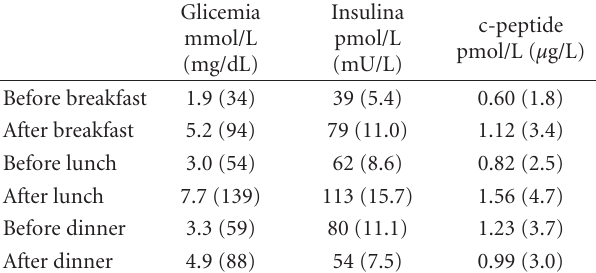
Table 1: Daytime glucose, insulin and c-peptide variations during hospital stay. Insulin and c-peptide were measured using automated immunoassays from American Systems DPS (Diagnostic Products (cid:2) Corporation) optimized on a Siemens Immulite 2000 c